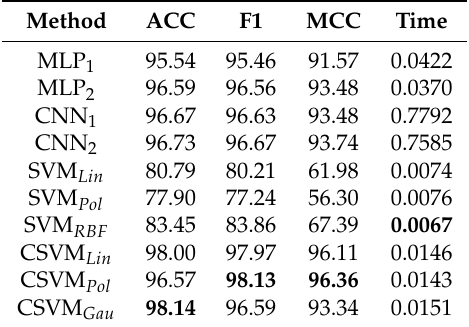
Table 6. Performance results. MLP1 corresponds to the model with more parameters, while MLP2 corresponds to the model with fewer parameters. The same applies to the CNN models. The time column refers to the training time.The suitable metrics are highlighted in